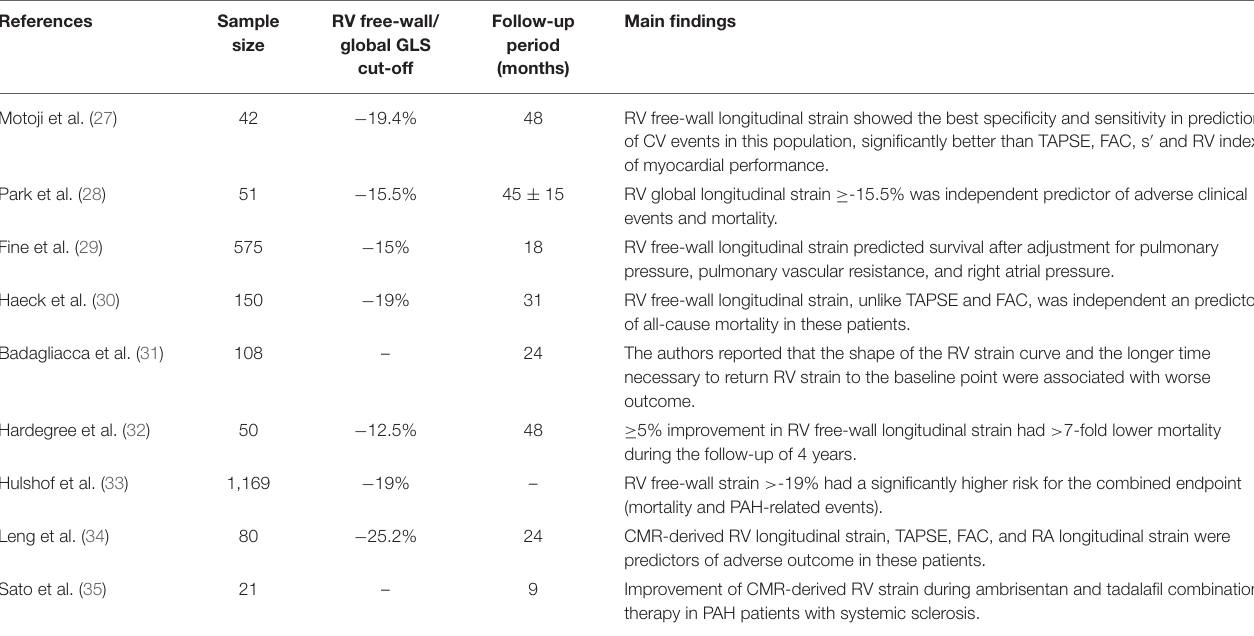
TABLE 2 | Predictive value of RV longitudinal strain in pulmonary